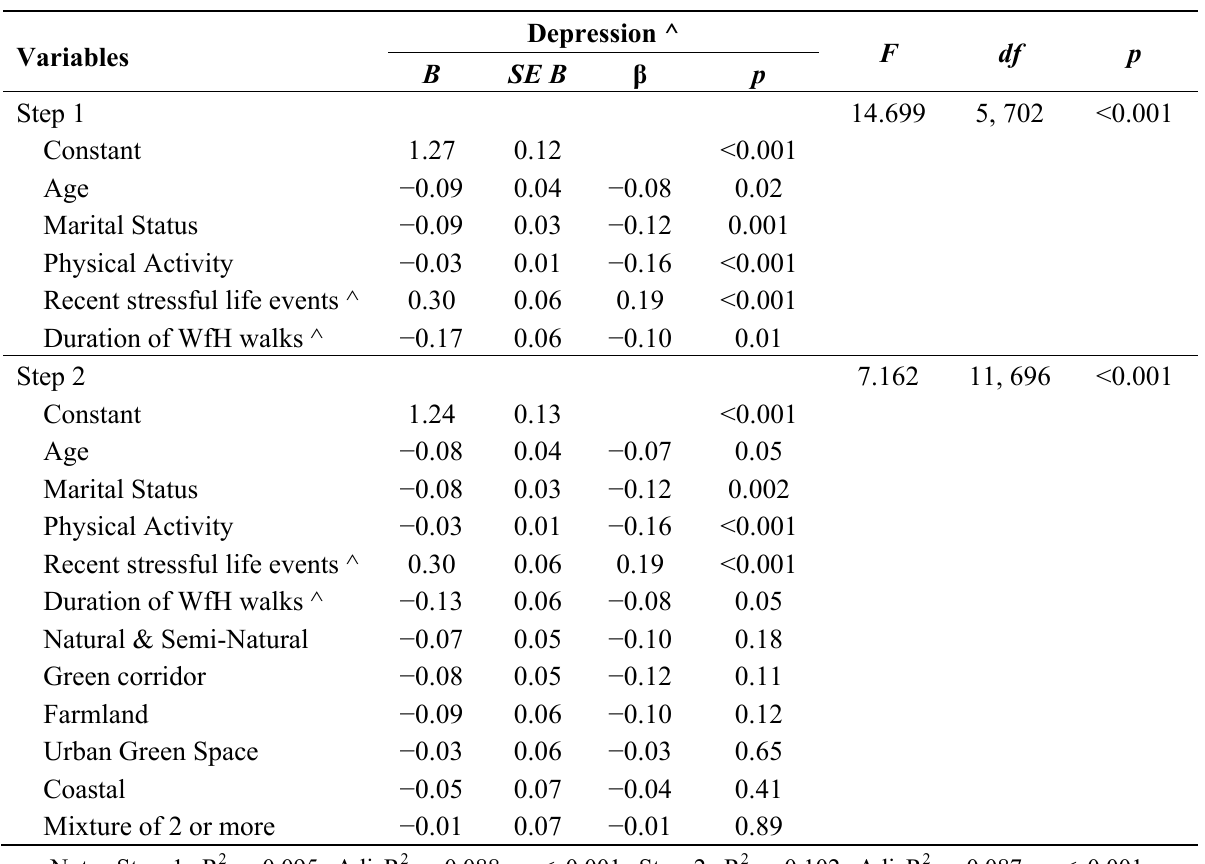
Table 6. Hierarchical regression analyses for variables predicting log-transformed depression of frequent group walkers attending at least once a week ( n =